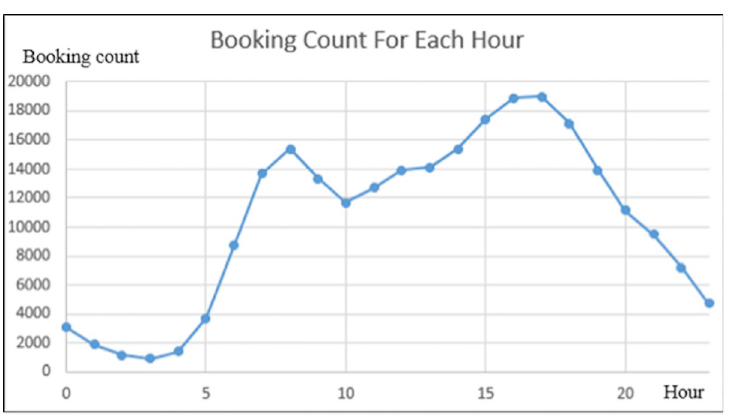
Fig 3. Number of bookings per hour.